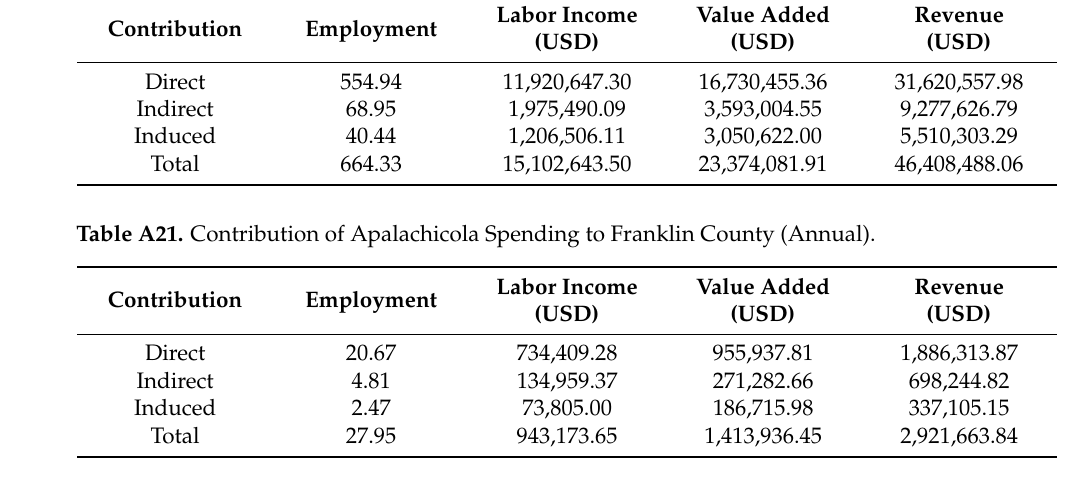
Table A22. Contribution of Apalachicola Visitation to Franklin County (Annual).